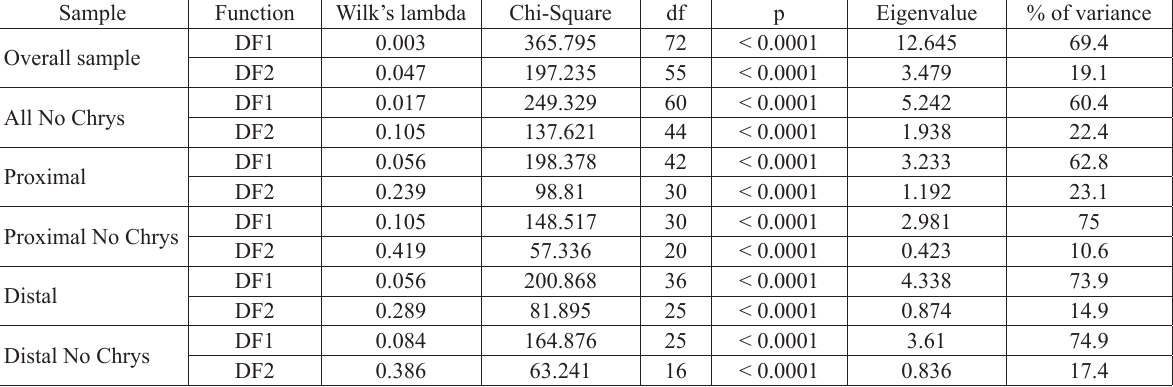
Table 2. Basic statistics for the discriminant functions used to predict genera under different sample regimes. No Chrys, all species except Chrysocyon. Sample Function Wilk’s lambda Overall